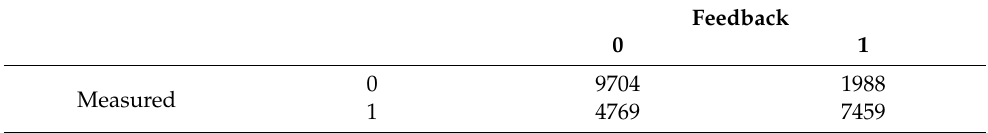
Table 6. The confusion matrix of features extracted before video-labeling validation.